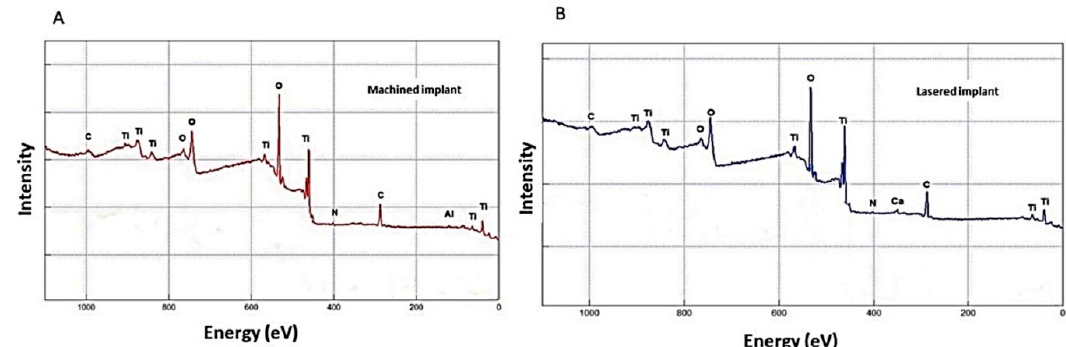
Figure 1. ( A ) XPS spectra of the implant surface of machined samples. The prominent photoemission peaks of the different elements present on the surface are highlighted. ( B ) XPS spectra of the implant surface of laser texture samples. The main photoemission peaks of the different elements present on the surface are highlighted.